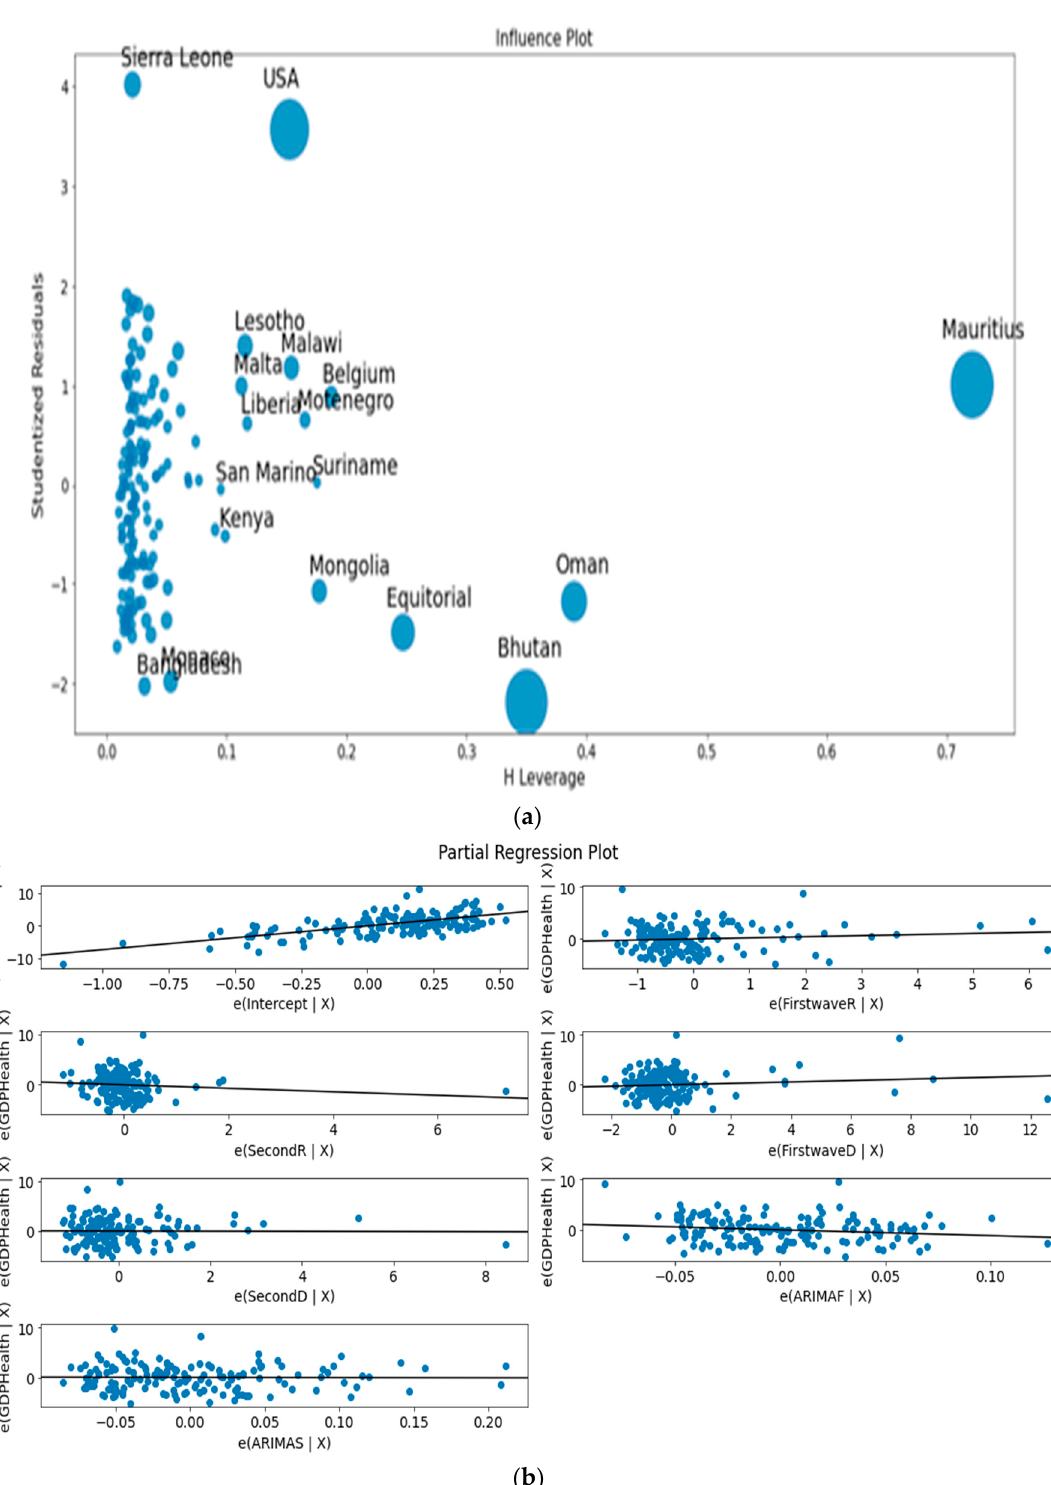
Figure 13. ( a ) Leverage vs normalized squared residuals plot. ( b ) Residuals regression plots for initial variables.